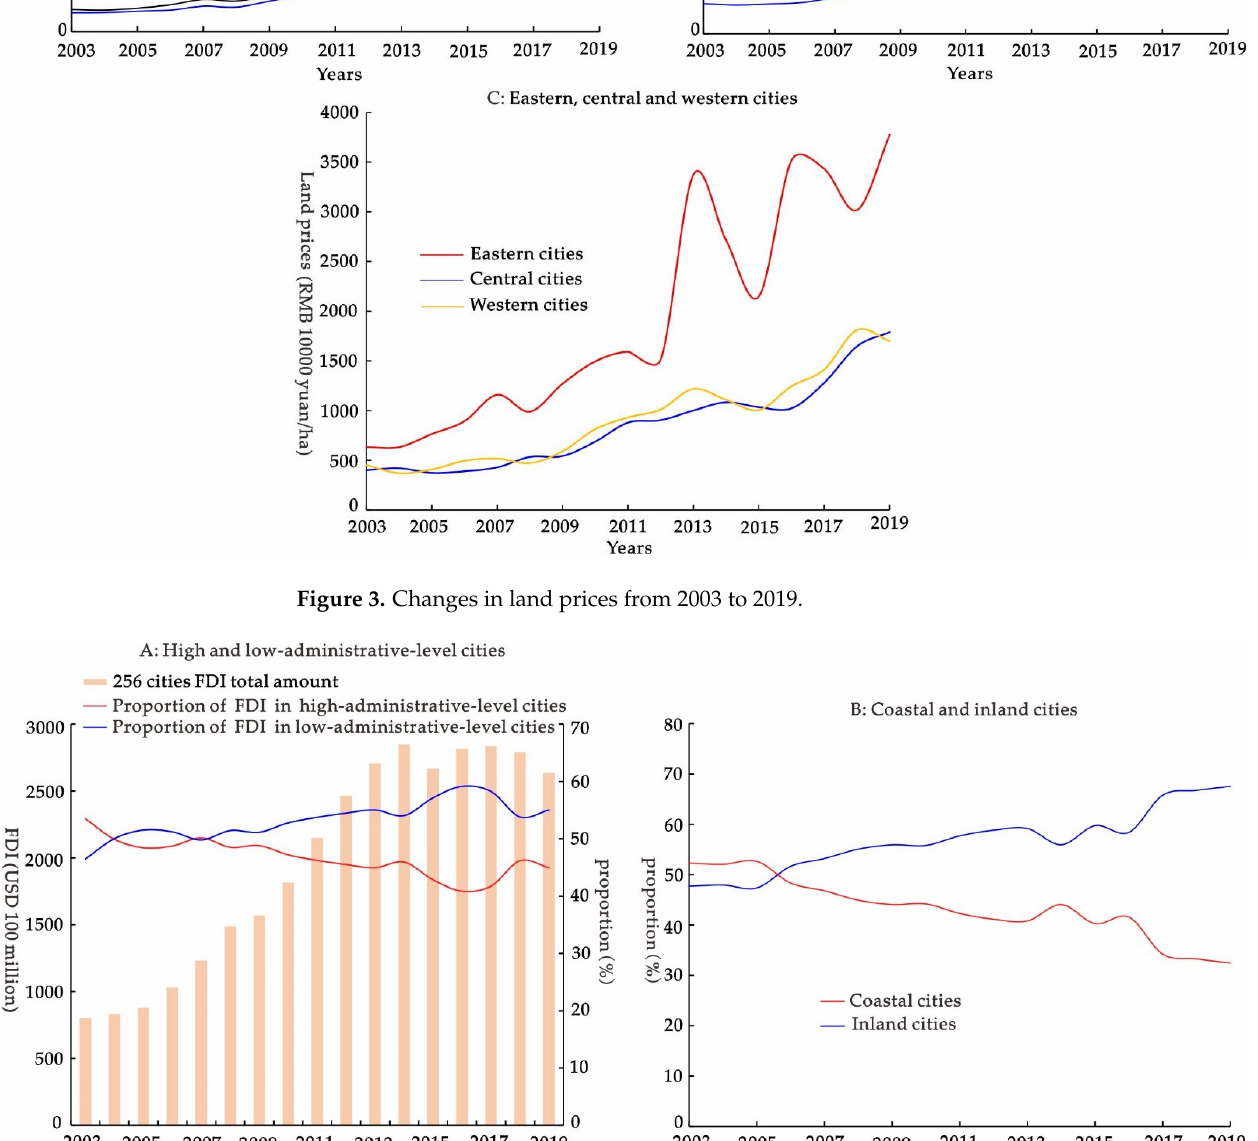
Figure 4. Changes in FDI from 2003 to 2019.